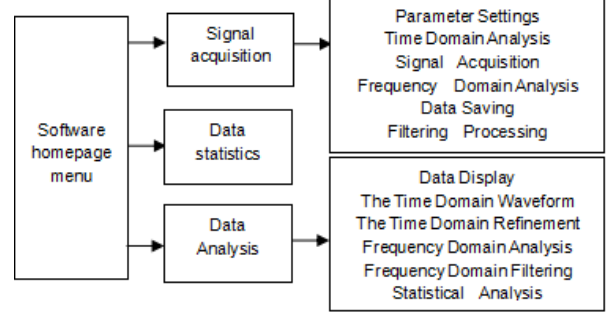
Fig. 2 Software structure design.